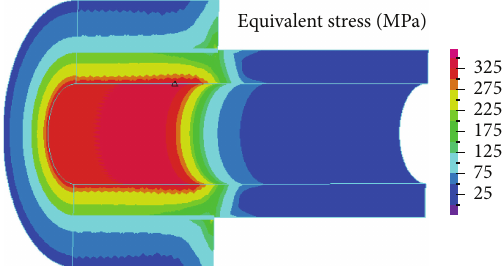
Figure 5: Normal contact stress of the contact surface.